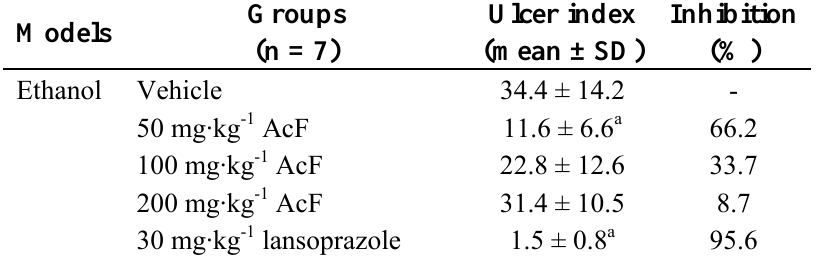
The columns are the mean ± S.D. of six rats. Different letters indicate significant differences.